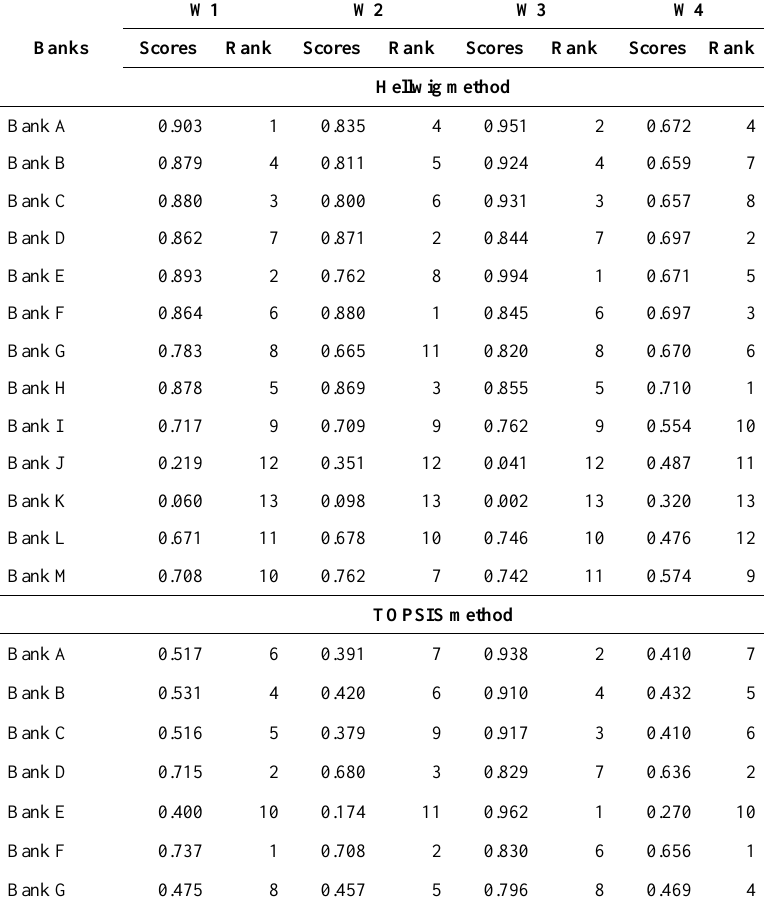
Table 9. Overall performance scores and ranks – Option